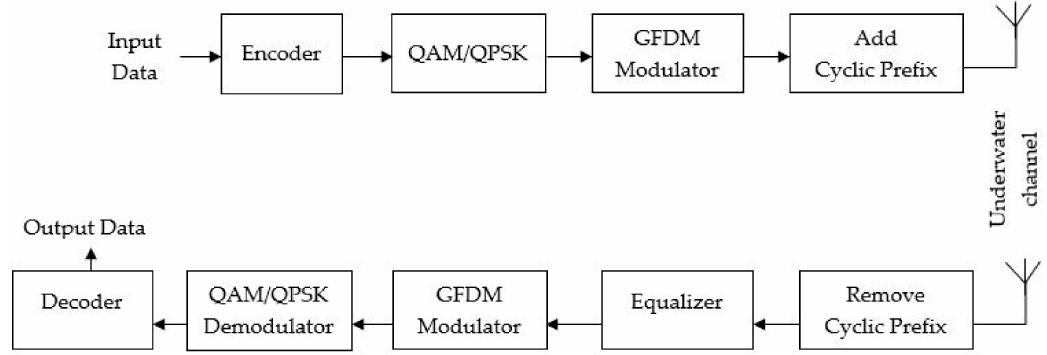
Figure 12. GFDM transceiver block diagram of